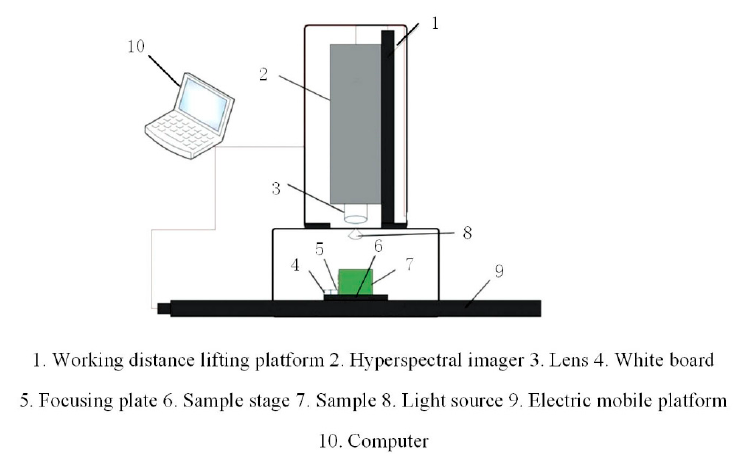
Figure 1. Structure diagram of hyperspectral imaging system.